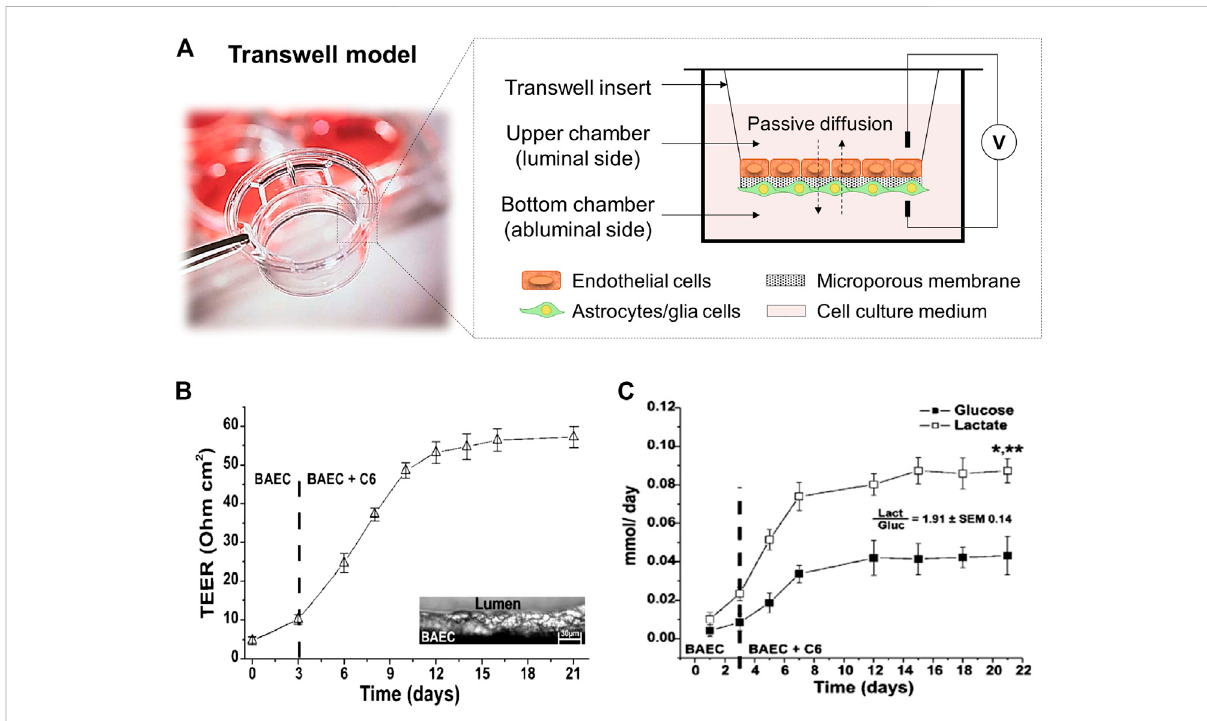
FIGURE 3 (A) Scheme of a Transwell cell coculture contact model divided by a fl at microporous membrane. ECs are seeded on the luminal side of the membrane (upper chamber) and astrocytes on the abluminal side (bottom chamber). The diffusion of compounds occurs side-by-side across the membrane. It is presented a picture of a Corning ™ Transwell ™ multiple well plate with permeable polyester membrane inserts provided by Fisher Scienti fi c(ThermoFisherScienti fi c,2022). (B) TEERvaluesachievedinaTranswellcoculturemodelofBAECandC6gliacellsfor21days,and (C) cell metabolism expressedthrough glucose consumption (mmol/day)and lactate production (mmol/day).The ratio between thelactateproduction and the glucose consumption is around two demonstrating an anaerobic metabolic pathway for cells cultured under static conditions. *, p < 0.05 refers to a statistically signi fi cant metabolic increase and **, p < 0.05 represents the statistically signi fi cant differences between glucose consumption and lactate production. Both graphs has been reprinted with permission from (Santaguida et al.,